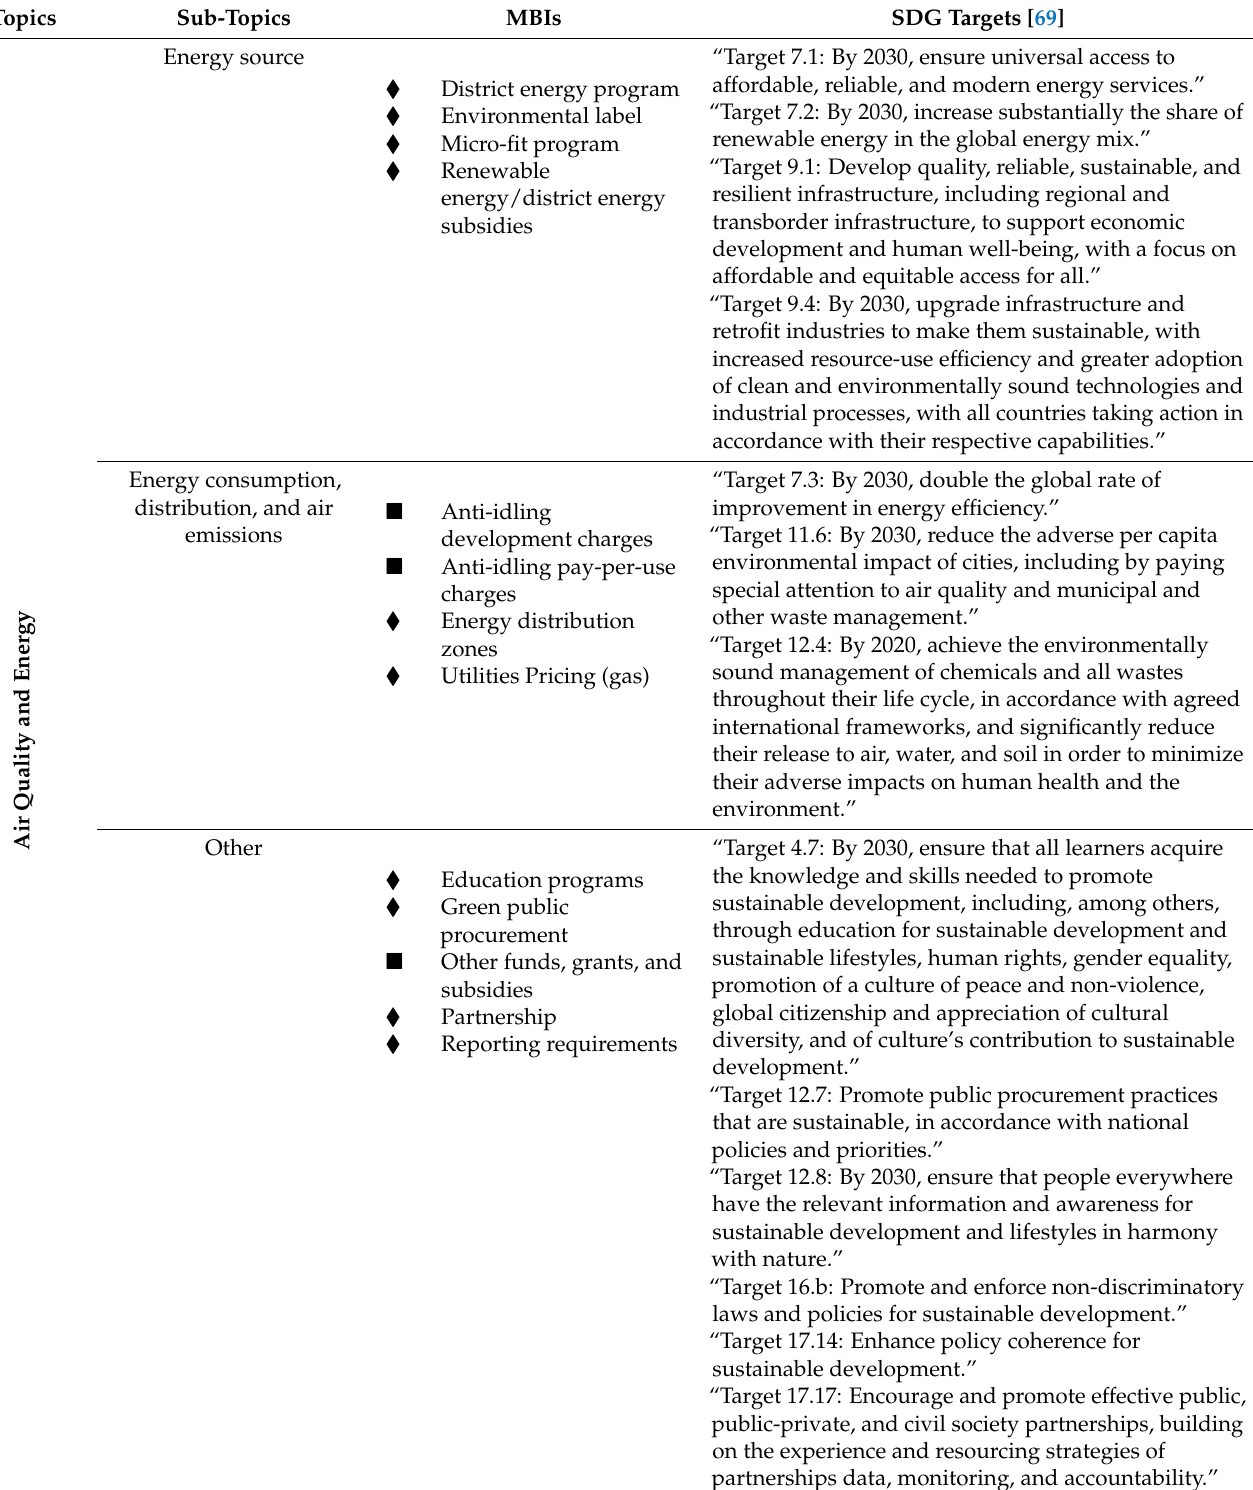
Table 6. Categorization of MBIs for Air Quality and Energy, and Related SDG Implementation.